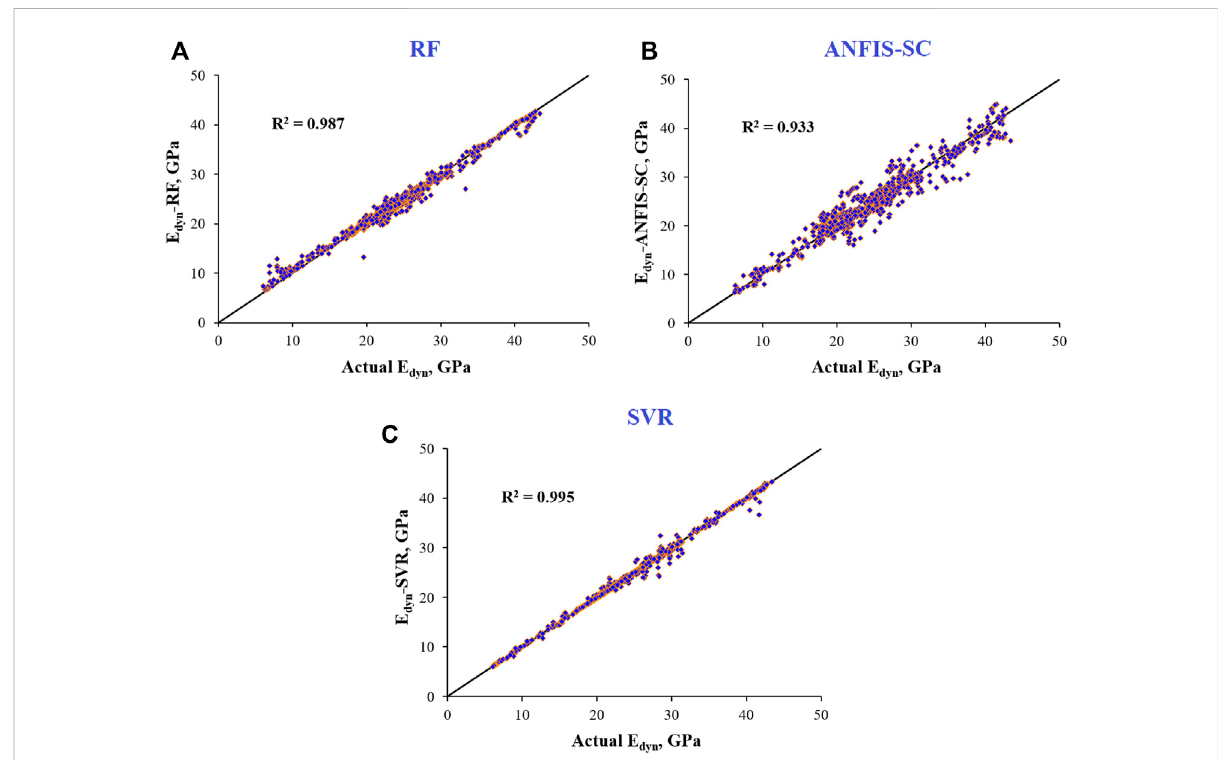
FIGURE 6 Cross-plots of the actual and assessed E dyn by the optimized (A) RF, (B) ANFIS-SC, and (C) SVR models for the 871 testing data points of